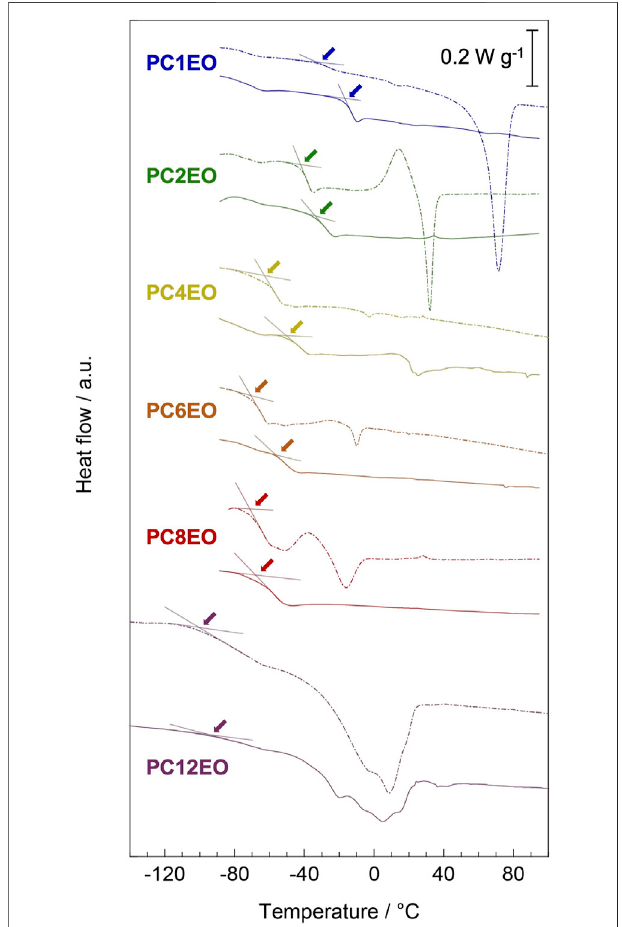
FIGURE 3 | Differential scanning calorimetry (DSC) curves for PCmEO (dash line) and PCmEO-LiTFSA (solid line) were recorded during the heating step from − 100 to 120 ° C (PC12EO and PC12EO-LiTFSA were heated from − 150 ° C) after pre-heating up to 120 ° C under N fl ow. Guidelines and 2 arrows indicate the glass transition